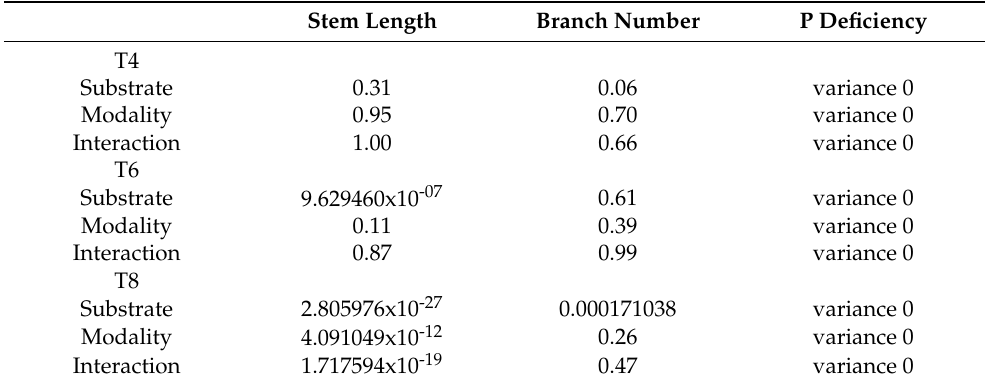
Table 4. Probabilities obtained with two-way ANOVA ( p -value threshold 0.05) performed on stem length, branch number and P deficiency at T4, T6 and T8. Stem